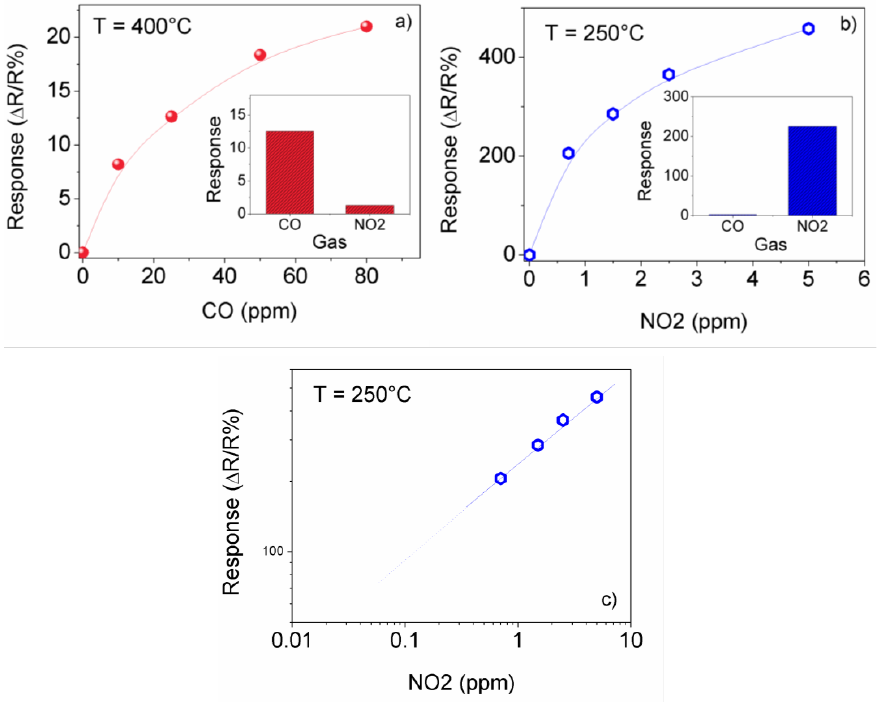
Figure 6. Calibration curves for ( a ) CO and ( b ) NO 2 . In the insets are shown the response to CO (25 ppm) and NO 2 (0.75 ppm). ( c ) Log-log plot of the NO 2 calibration extrapolated to low concentration levels.